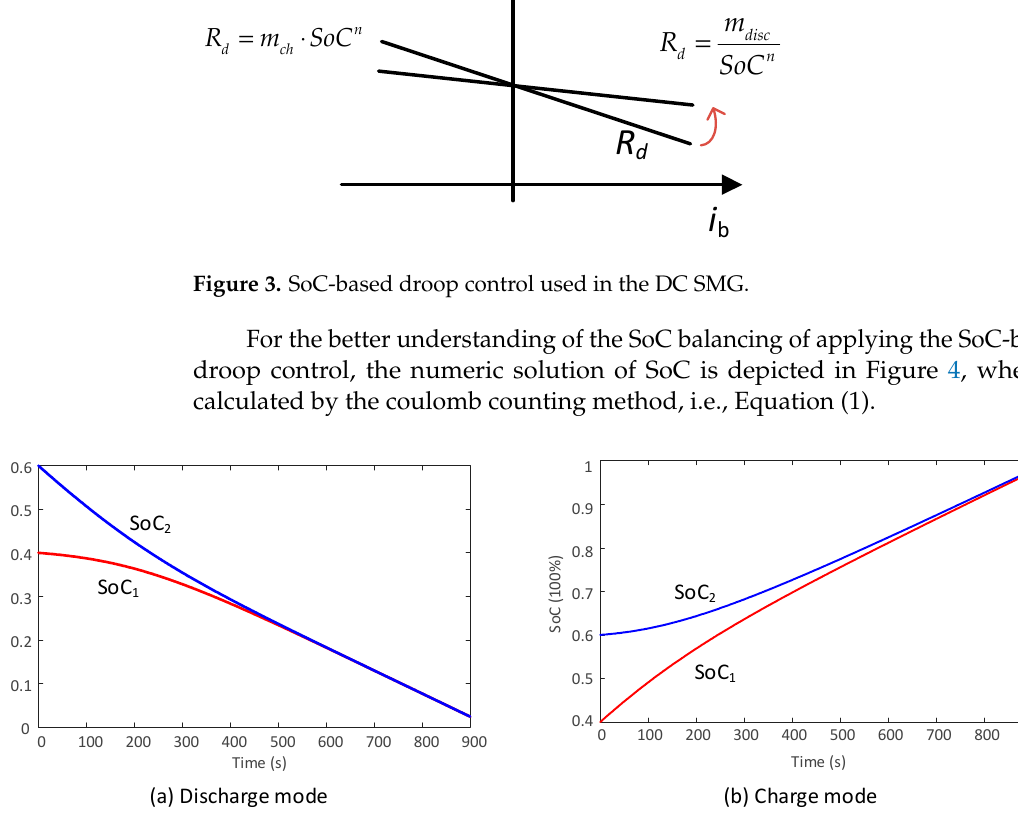
Figure 4. Numeric solution of SoC ( n = 6).